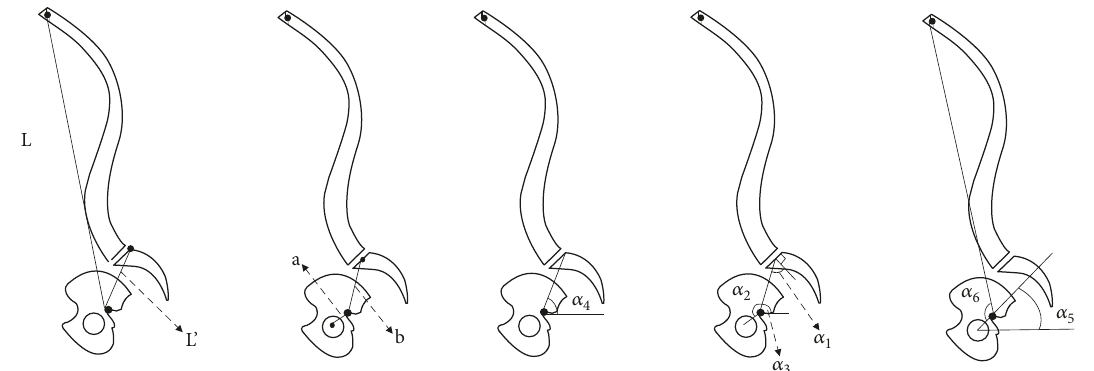
Figure 3: Lateral spine diagram showing angles used in the predictive